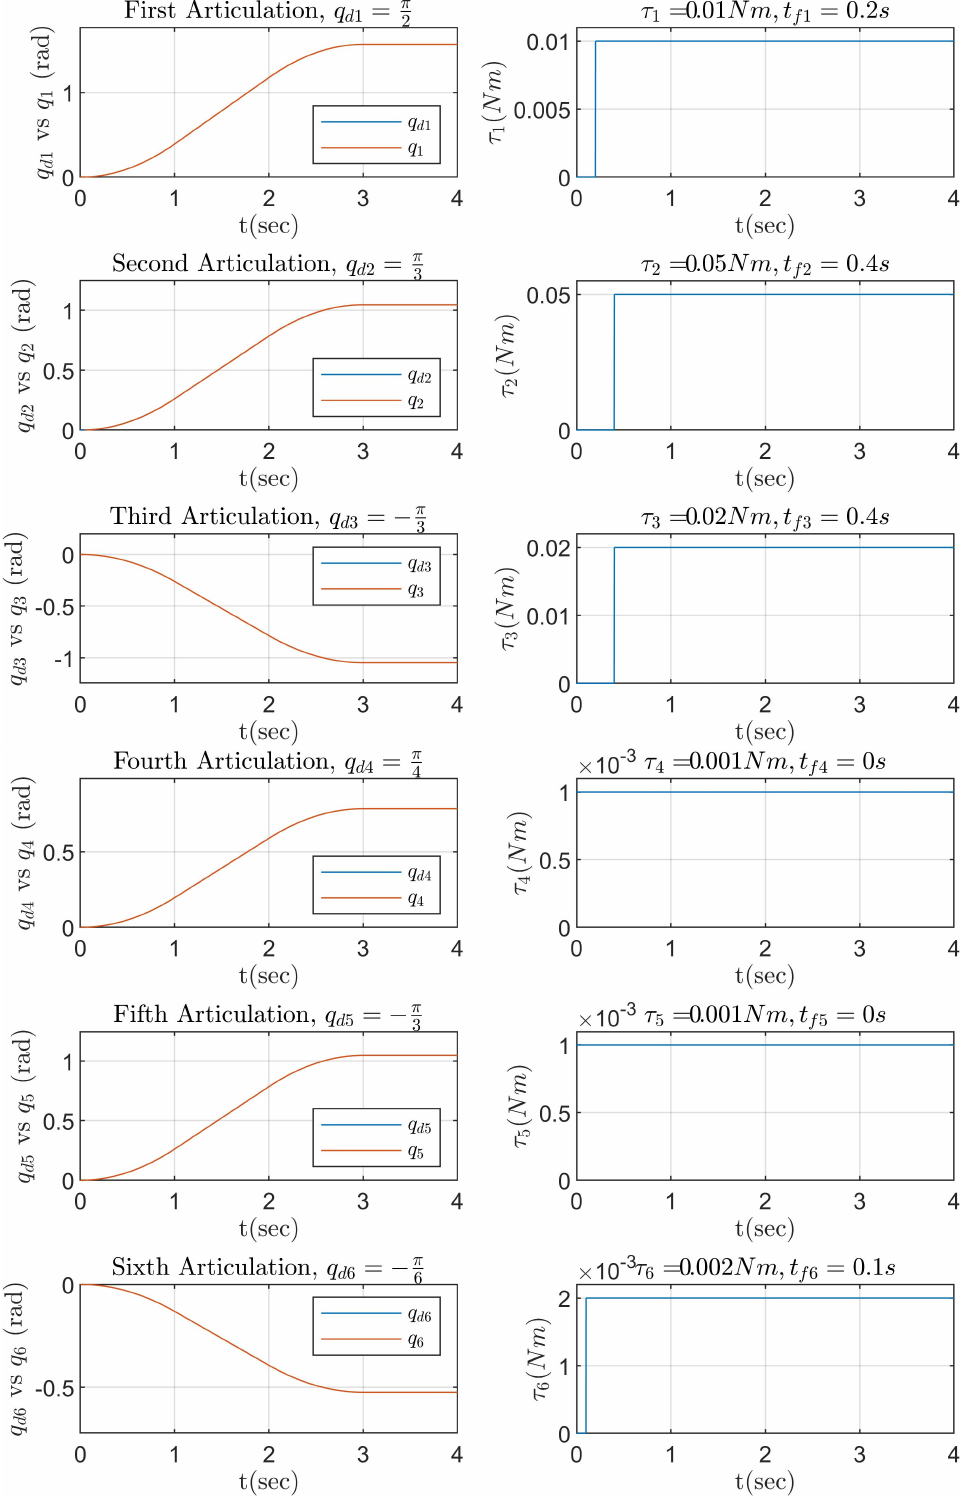
Figure 5. Simulation of the SMC with perturbations using numerical